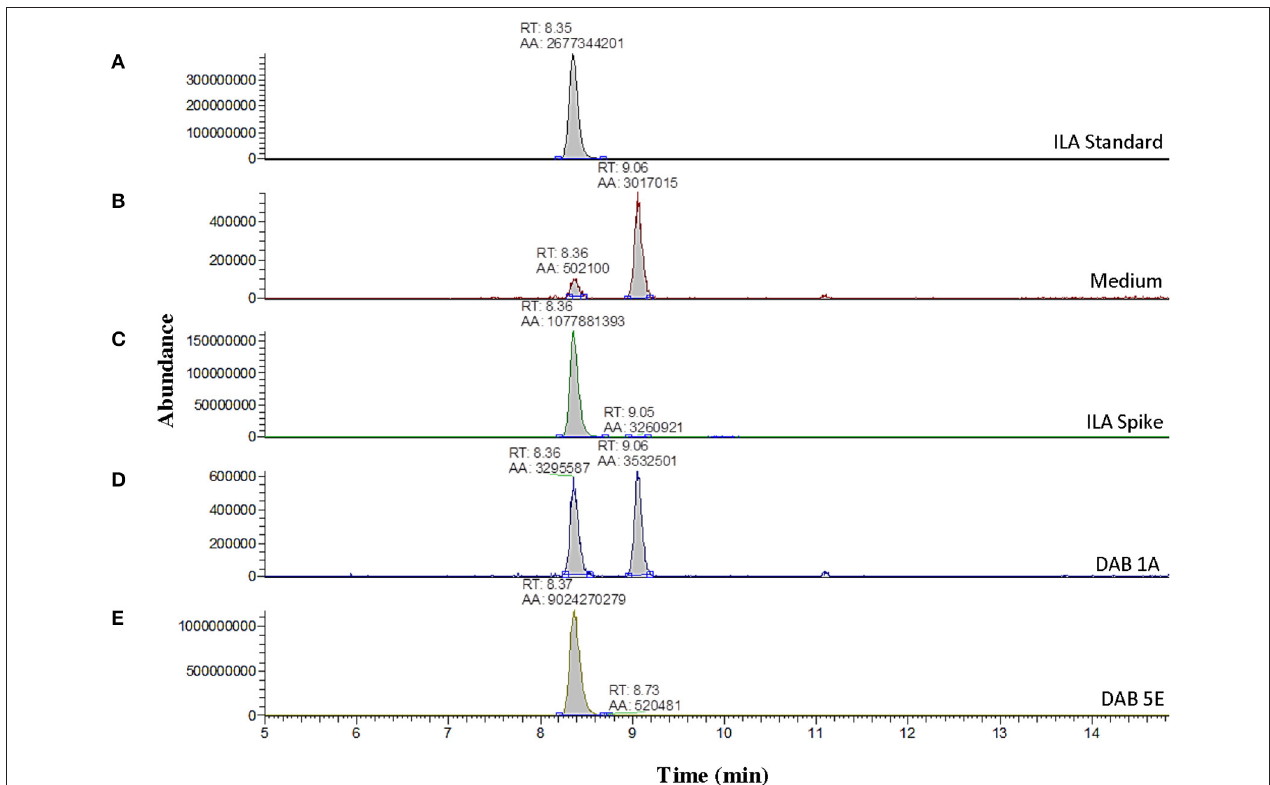
FIGURE 4 | Detection of indole-3-lactic acid production in two DABs by mass spectrometry. LC-MS extracted negative ionization ion chromatograms at m/z 204.06 to m/z 204.07 ([M-H] of ILA). RT, retention time; AA, automatic area under peak. (A) EIC of an injection of 100 ng/ µ L of free ILA suspended in 100% acetonitrile showing a retention time of 8.35min. (B) EIC showing a background signal at the RT of free ILA in the LB medium sample. A second signal is detected at a retention time of 9.06min in the LB medium. (C) EIC from the LB medium spiked with 100 ng/ µ L of ILA. (D) EIC from the LB medium with pink-type Microbacterium strain, DAB 1A. (E) EIC from the LB medium with pink-type Herbaspirillum strain, DAB 5E. The scales on the Y-axis are automatically adjusted to show all the peaks in each of the chromatograms. Note the different scale on the chromatograms in (B,D) to show the lower quantity